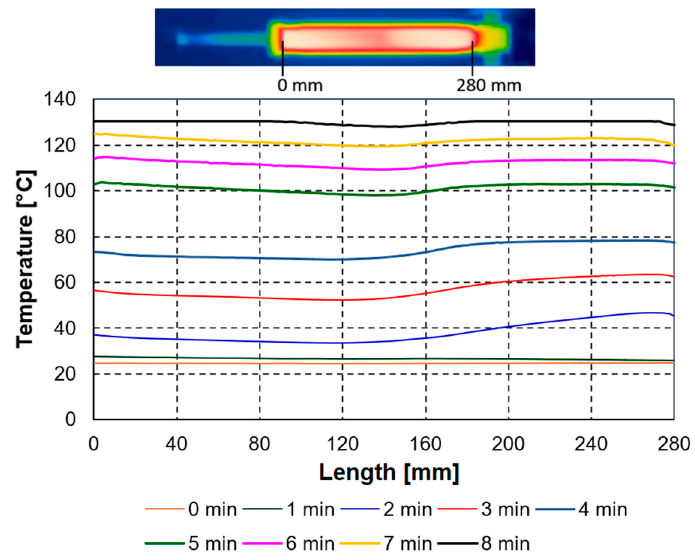
Figure 6. Temperature changes at the surface (along the shock absorber axis).